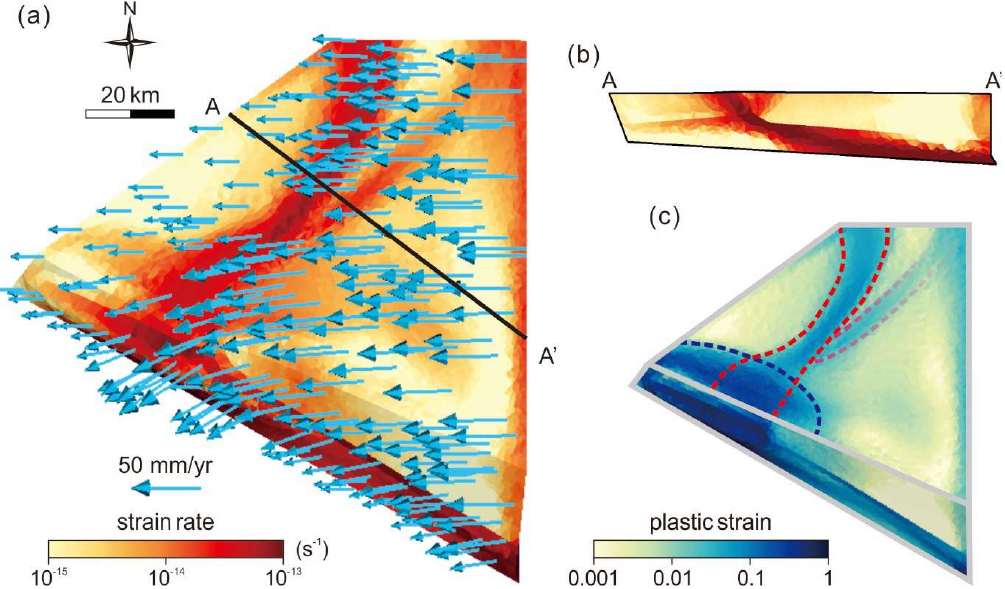
Figure 4. ( a ) The strain rate field and surface velocity field of the model at 40 kyr. 𝐴𝐴′ is the profile perpendicular to the forethrust along the ramp. ( b ) The strain rate field of profile 𝐴𝐴′ . ( c ) The plastic strain field of the model at time = 40 kyr. The red dashed lines mark the forethrust. The purple dashed lines mark the backthrust. The blue dashed line marks the slumping area.